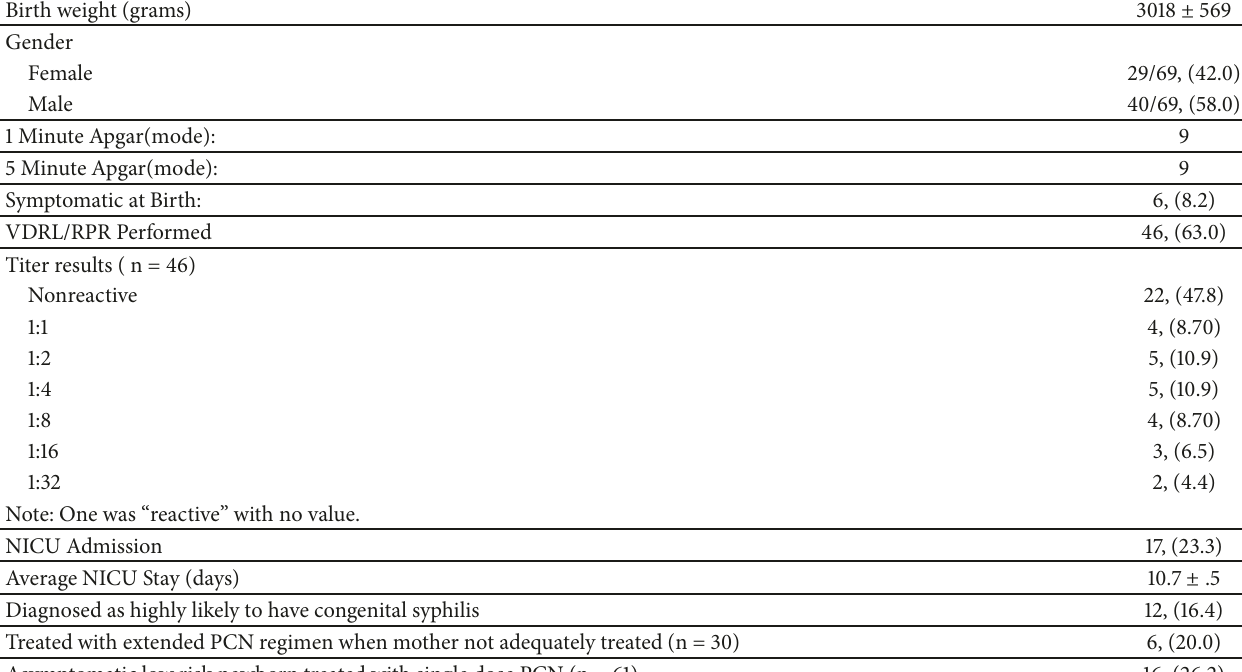
Table 4: Neonatal variables: N = 73 unless otherwise